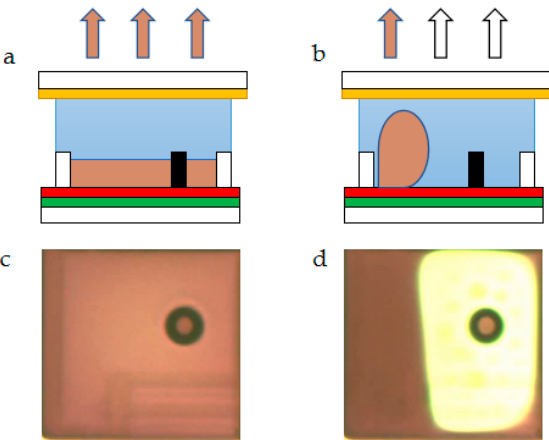
Figure 2. EWD principle. ( a ) The oil is spread over the entire pixel when the pixel is turned o ff . ( b ) The oil is pushed to a corner in the pixel when the pixel is turned on. ( c ) The top view when the pixel is turned o ff . ( d ) The top view when the pixel is turned on.